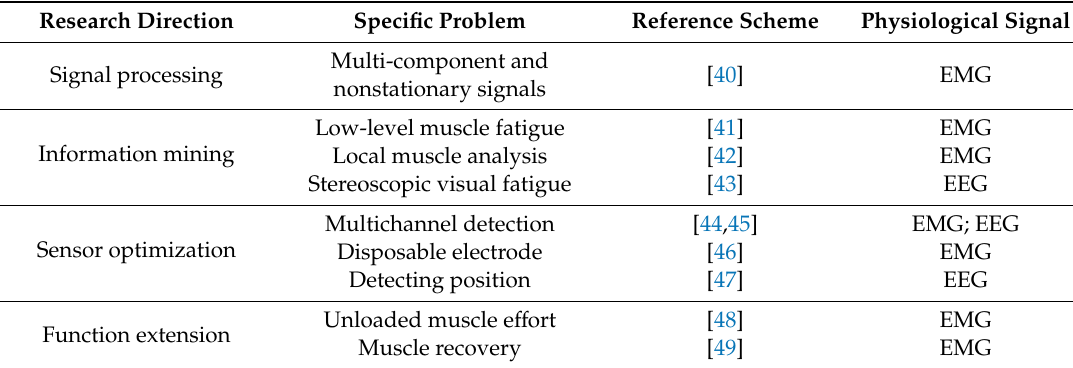
Table 2. Research directions for and the specific problems of Fatigue Detection Systems